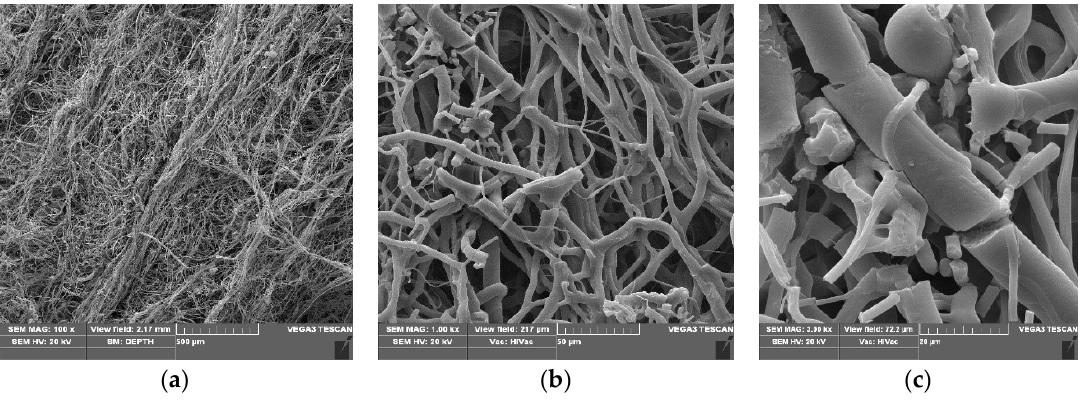
Figure 3. SEM images of PLA–Cu 0 (30), magnification: ( a ) 100×, ( b ) 1000×, ( c ) 3000×.